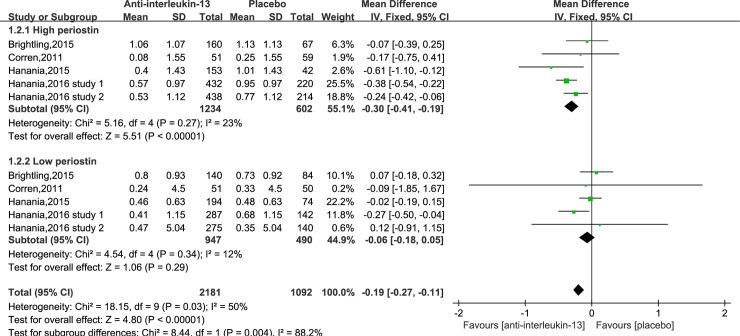
Forest plot comparing anti-IL-13 and placebo with rate of asthma exacerbation.